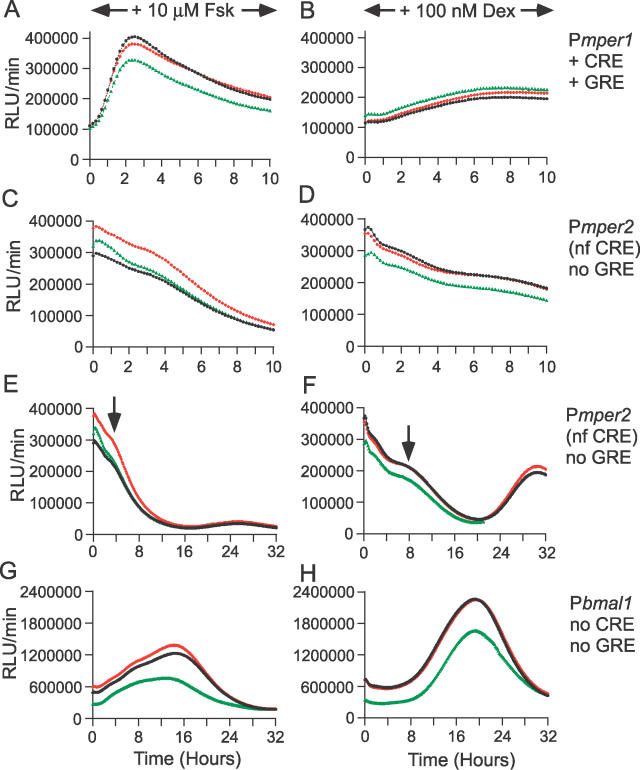
Effect of Continuous Stimulation by Fsk and DexPromoter activities of P3.0kb-mper1, Pmper2, Pbmal1 (Rat-1 cell line nos. 5–100, 3–72, and 5–66, respectively) were monitored in the continuous presence of either 10 μM Fsk or 100 nM Dex. Time 0 is when the Fsk/Dex was added. Three replicates are shown for each treatment.(A) Rat-1/P3.0kb-mper1::dLuc cells in the continuous presence of 10 μM Fsk.(B) Rat-1/P3.0kb-mper1::dLuc cells in the continuous presence of 100 nM Dex.(C) Rat-1/Pmper2::dLuc cells in the continuous presence of 10 μM Fsk. NF, nonfunctional.(D) Rat-1/Pmper2::dLuc cells in the continuous presence of 100 nM Dex.(E) Same as (C), except the time scale was expanded to 32 h. Arrows indicate the initiation of rhythmic components.(F) Same as (D), except the time scale was expanded to 32 h. Arrows indicate the initiation of rhythmic components.(G) Rat-1/Pbmal1::dLuc cells in the continuous presence of 10 μM Fsk.(H) Rat-1/Pbmal1::dLuc cells in the continuous presence of 100 nM Dex.